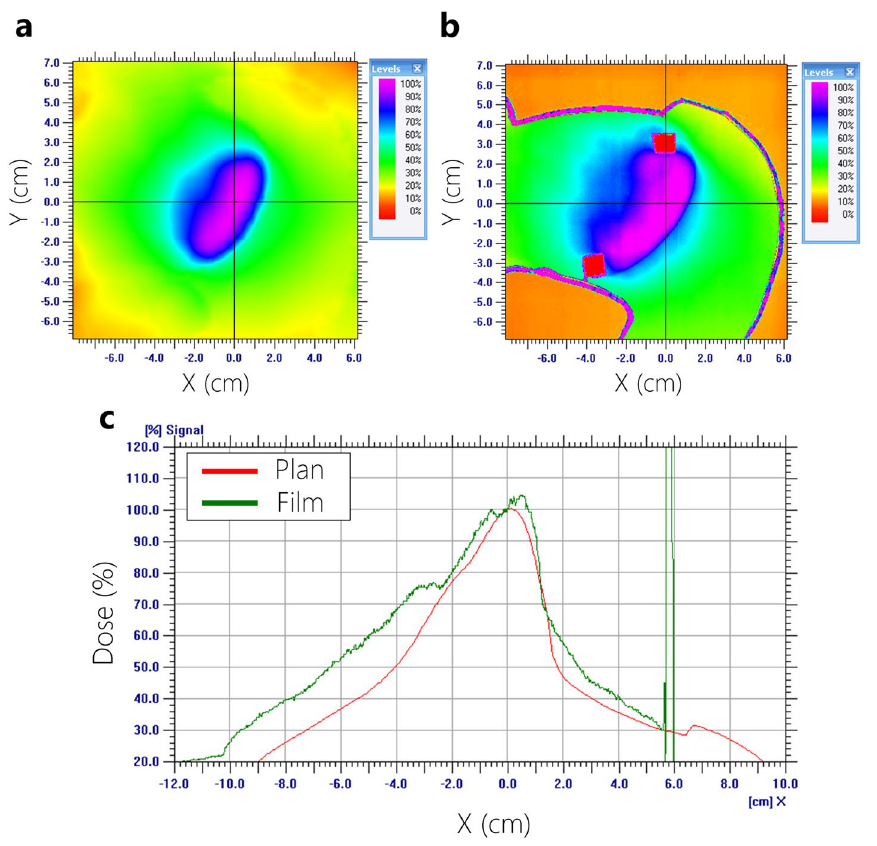
Figure 12. Dose profile analysis (measured film vs. planned dose) using 15-MV based on AXB Algorithm. ( a ) planned dose, ( b ) measured dose, ( c ) comparison of dose